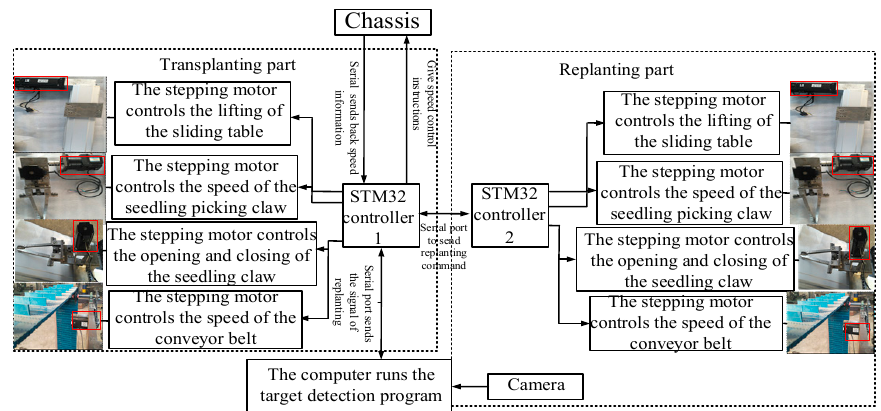
Figure 8. Control system diagram.